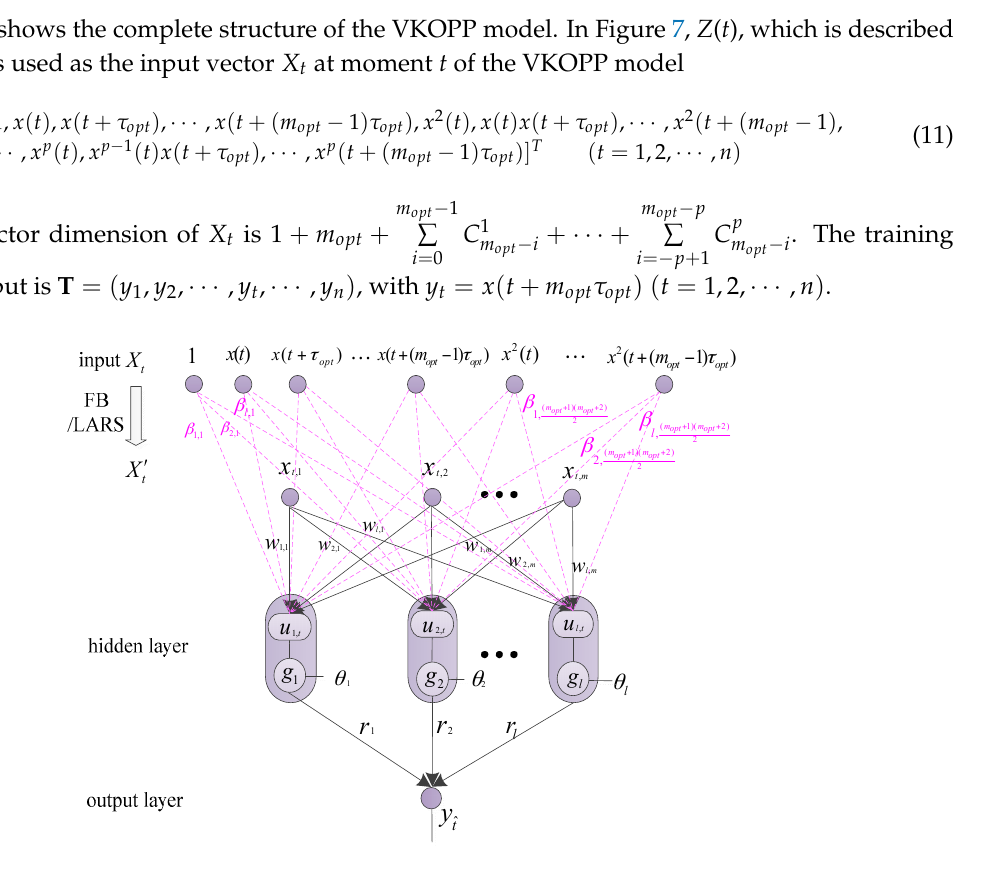
Figure 7. VKOPP complete structure.